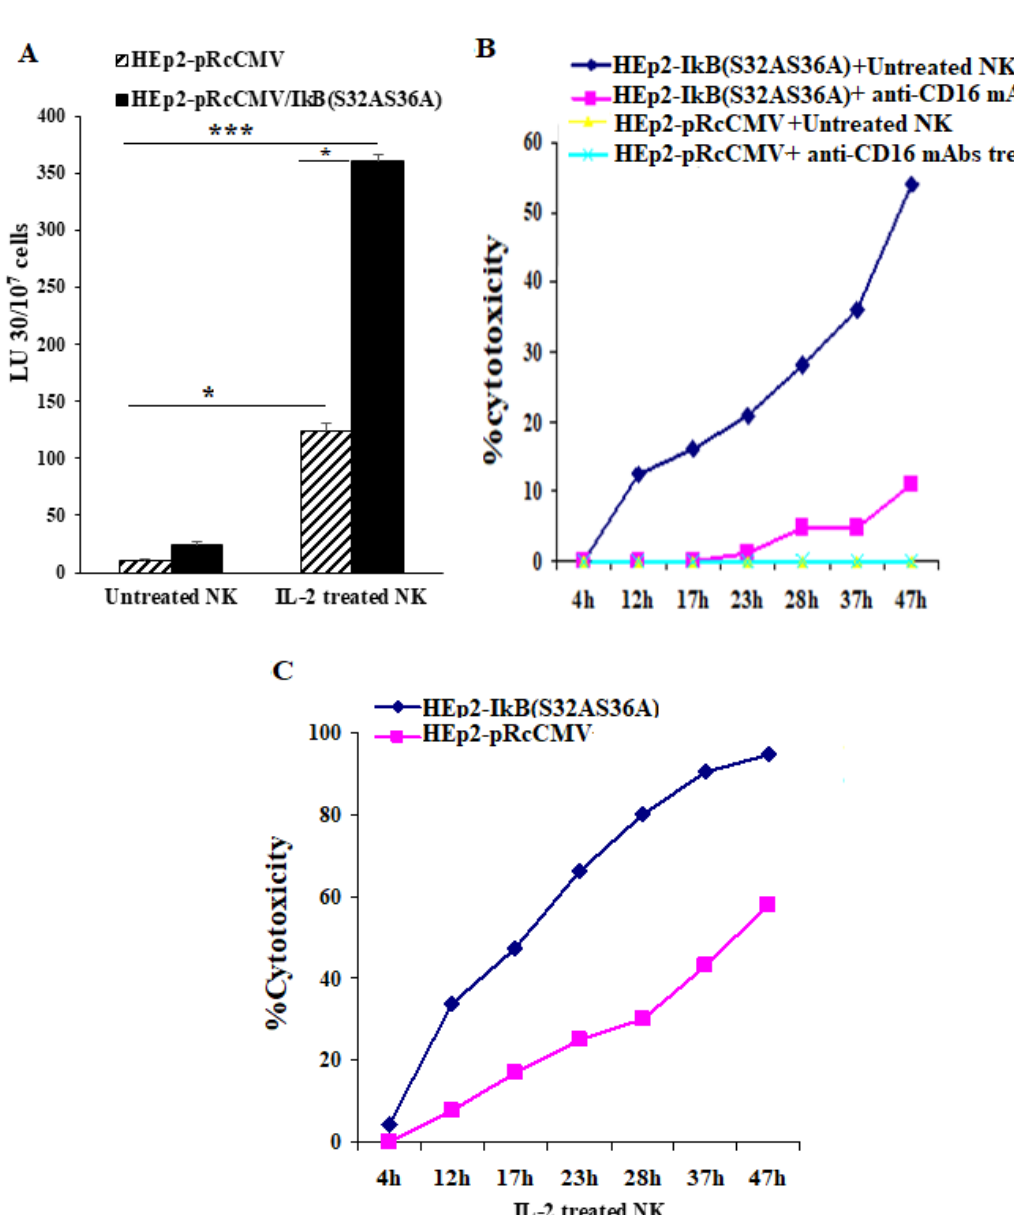
Figure 5. NF κ B blocking in HEp2 tumors increased their susceptibility to NK cell-mediated cytotoxicity. NK cells were left untreated and treated with IL-2 (500 U/mL) overnight before they were added to 51 Cr-labeled pRcCMV vector alone or I κ B(S32AS36A) transfected HEp2 cells at various effector-to-target ratios. NK cell-mediated cytotoxicity was measured using a standard 4-h 51 Cr release assay. The lytic units (LU) 30/10 7 cells were determined using the inverse number of NK cells required to lyse 30% of target cells × 100 ( A ). *** ( p value < 0.001), * ( p value 0.01–0.05). NK cells were left untreated and treated with anti-CD16 mAbs (3 µg/mL) overnight before they were added to 51 Cr-labeled pRcCMV vector alone or I κ B(S32AS36A) transfected HEp2 cells at various effector-to-target ratios. NK cell-mediated cytotoxicity was measured using xCELLigence Real Time Cell Analysis (RTCA) ( B ). NK cells were treated with IL-2 (500 U/mL) overnight before they were added to 51 Cr-labeled pRcCMV vector or and I κ B(S32AS36A) transfected HEp2 cells at various effector-to-target ratios. NK cell-mediated cytotoxicity was measured using xCELLigence Real Time Cell Analysis (RTCA) ( C ). One of four representative experiments is shown in this figure.